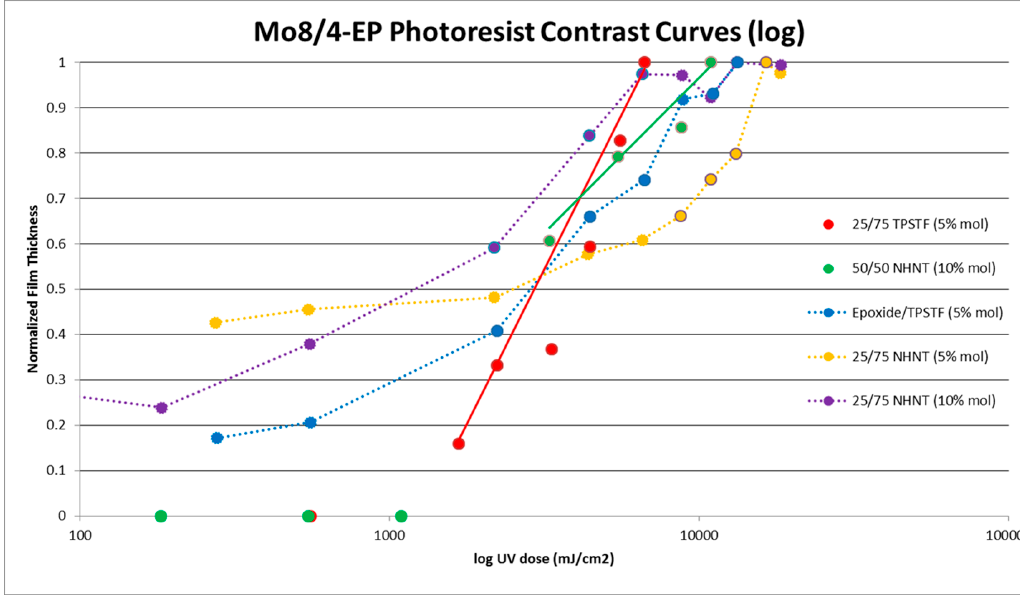
in Figure 4. Two mixtures—25:75 TPSTF and 50:50 NHNT—as mentioned above, showed “optimal”